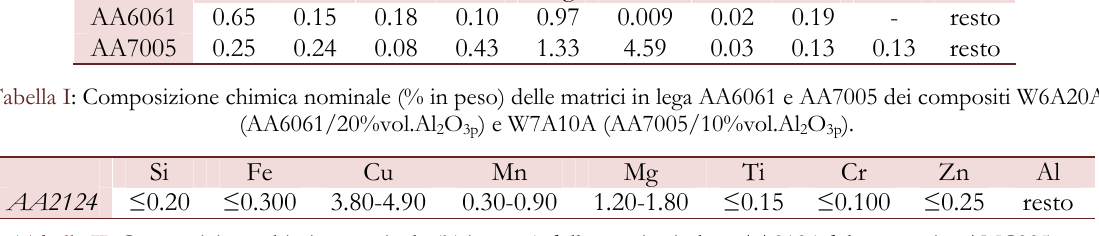
Tabella II: Composizione chimica nominale (% in peso) della matrice in lega AA2124 del composito AMC225xe. La caratterizzazione microstrutturale dei giunti e dei materiali base è stata effettuata con tecniche di microscopia